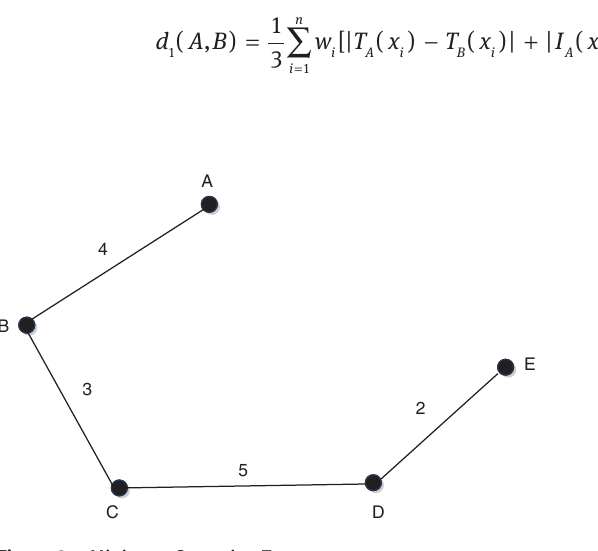
Figure 3. Minimum Spanning Tree.